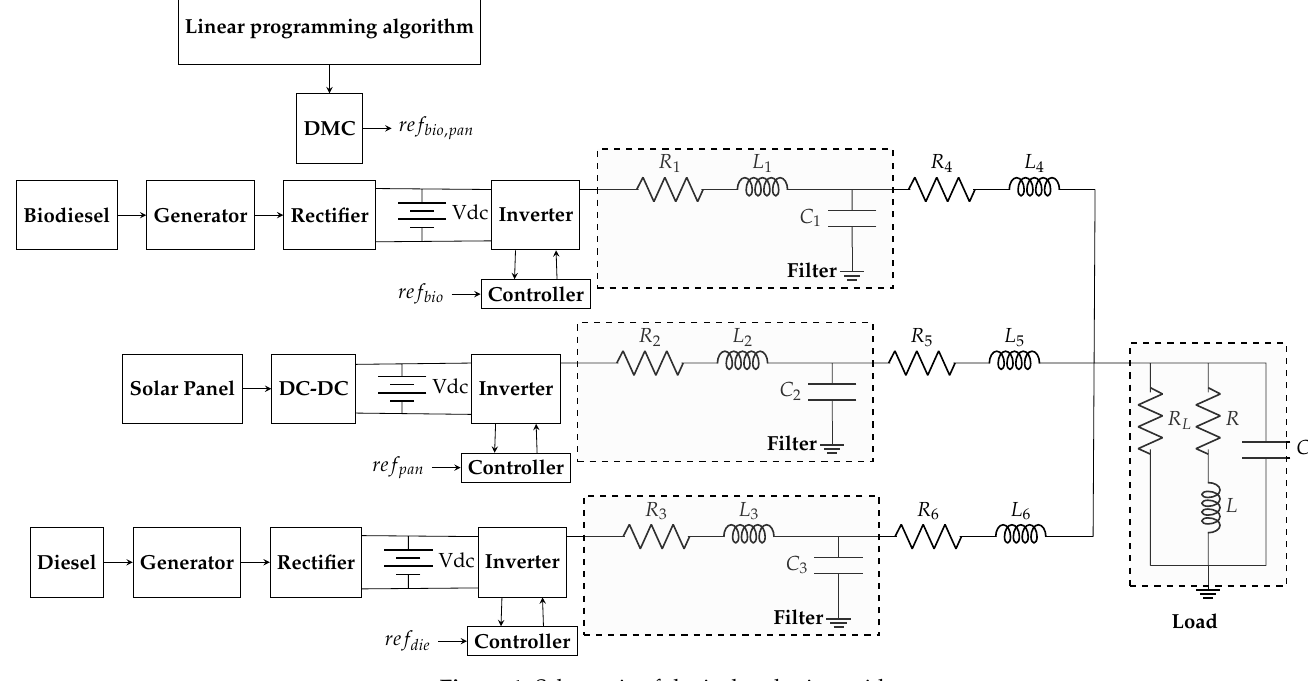
Figure 1. Schematic of the isolated